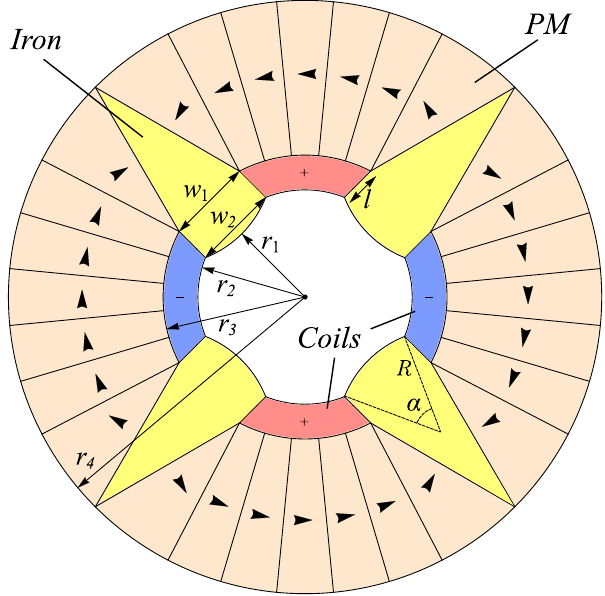
FIG. 7. Layout of hybrid magnet